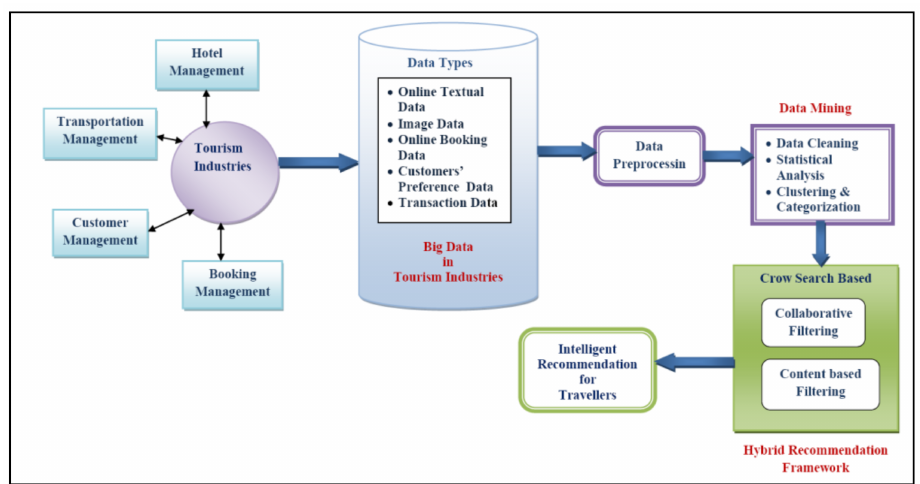
Figure 1. Impact of Big Data and Visualization of the Proposed